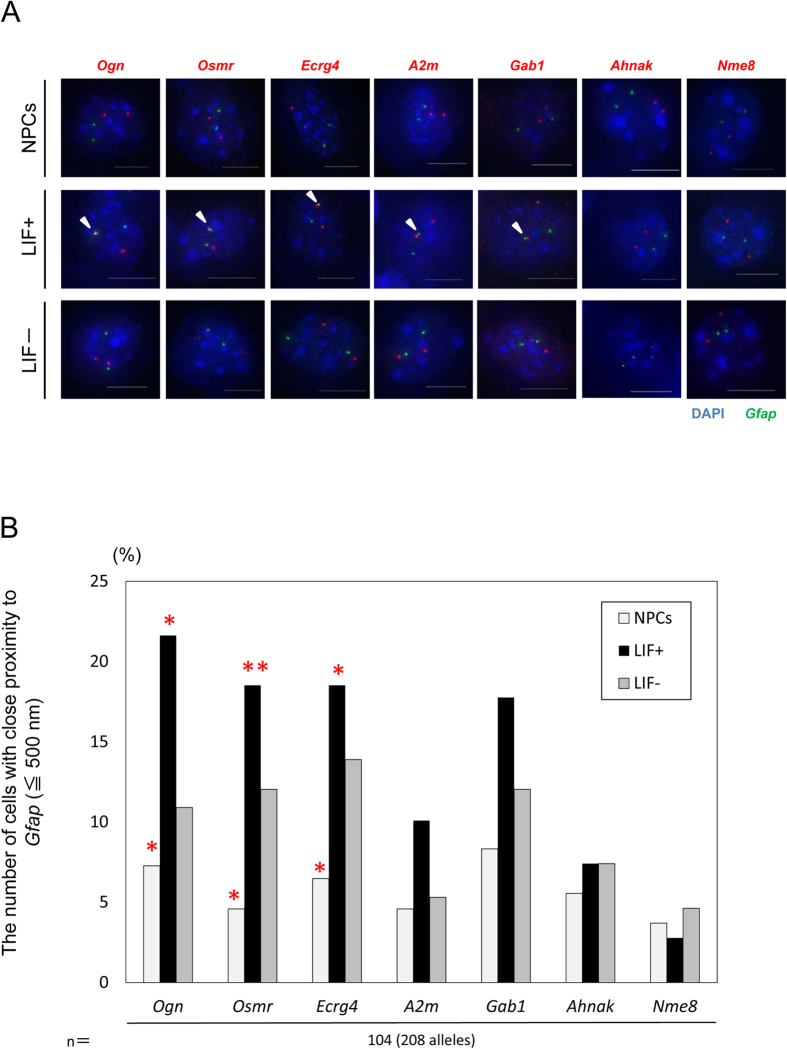
Validation of gene association between Gfap and five putative genes identified by Genechip and modified e4C.(A) Projected images of double-labeled DNA FISH in NPCs, LIF+, and LIF− cells for Gfap (green) and other genes (red). Nuclei were counterstained with DAPI (blue). Scale bar = 5 μm. (B) Association frequencies determined with DNA FISH for the indicated gene pairs in NPCs, LIF+, and LIF− cells. **P < 0.01, *P < 0.05. (C) Nuclear size as measured by DAPI staining in NPCs, LIF+, and LIF− cells. **P < 0.01, *P < 0.05.